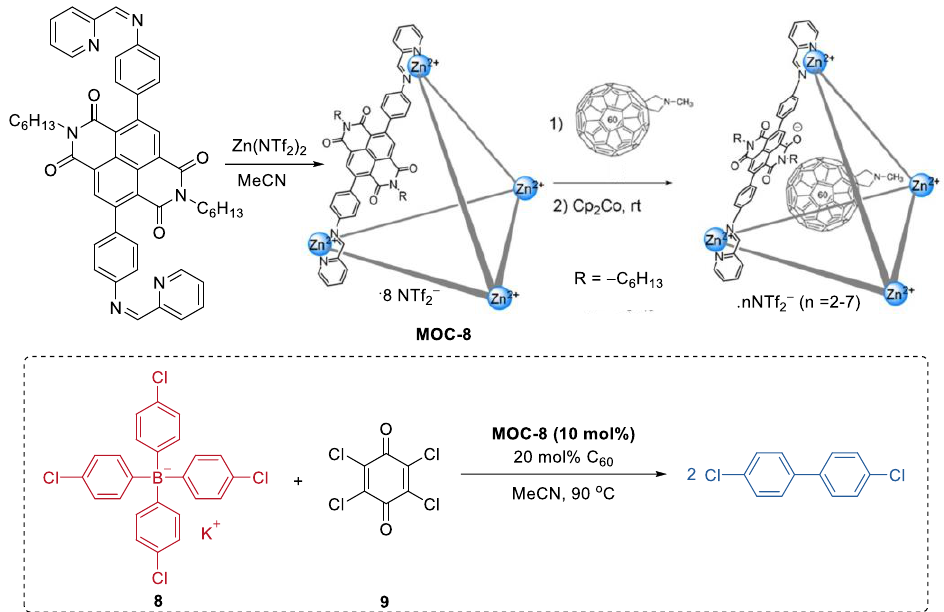
Figure 7. Oxidative coupling reaction of tetraaryl borates catalyzed by MOC-8 with encapsulated C 60 [60]. Reaction additions: 8 (0.014 mmol), MOC-8 (10 mol%), 9 (200 mol%), C 60 (20 mol%), MeCN, 90 °C. Reprinted/adapted with permission from Ref. [60]. Copyright 2019 Wiley VCH.